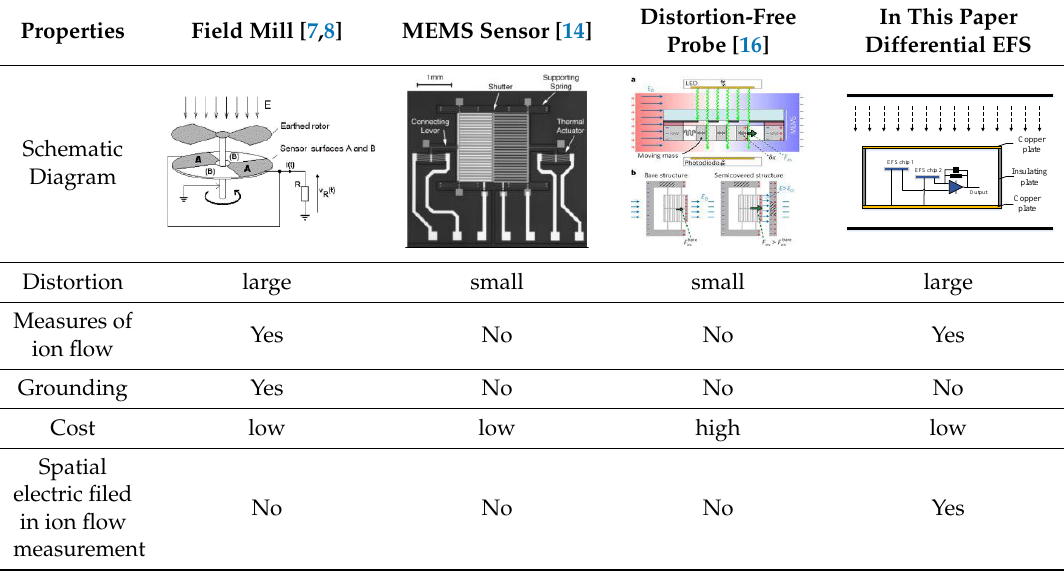
Table 1. Comparisons of electrical field sensor.